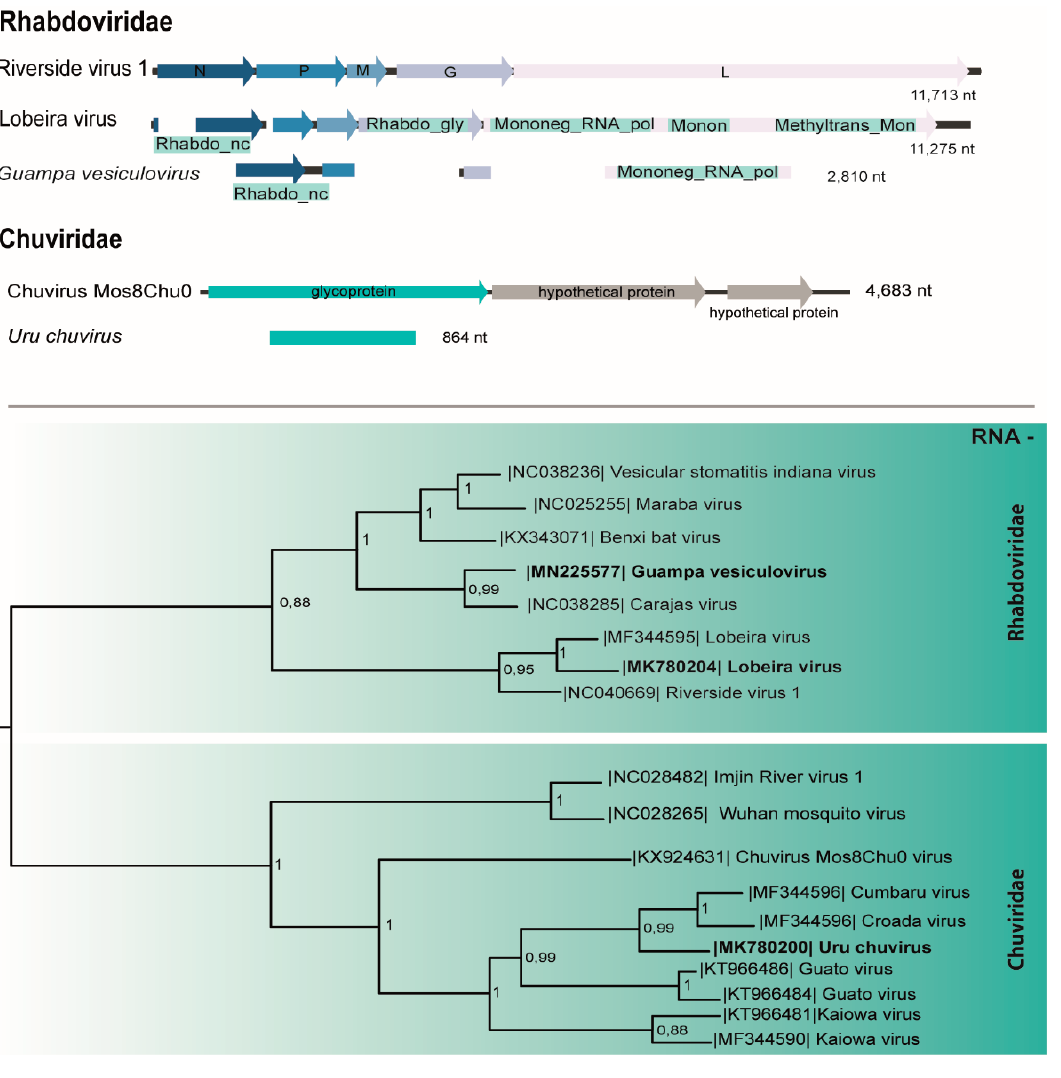
Figure 4. Genome map and the maximum likelihood phylogenetic tree of Guampa vesiculovirus, Lobeira virus, and Uru chuvirus members of Rhabdoviridae and Chuviridae families,